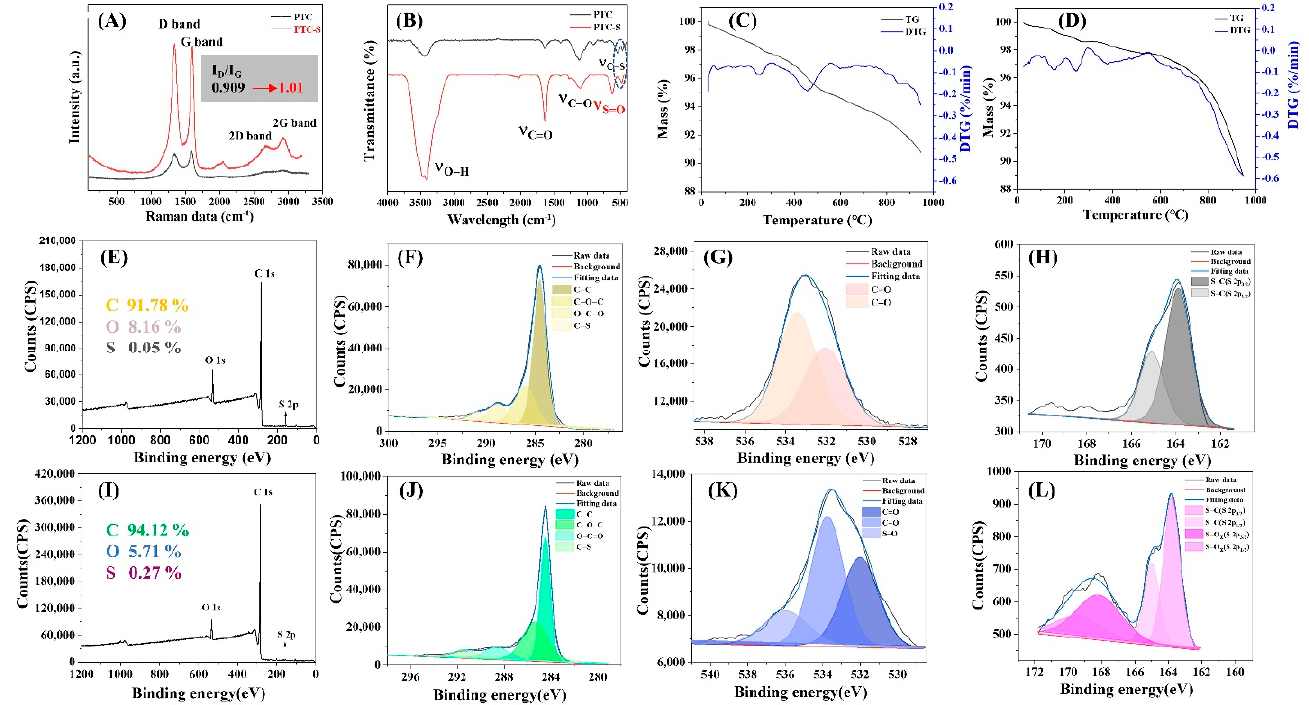
Figure 2. ( A ) Raman spectra and ( B ) FTIR spectra of PTC and PTC-S; ( C ) TG and DTG curves of PTC; ( D ) TG and DTG curves of PTC-S; ( E ) Survey, ( F ) C 1s, ( G ) O 1s, ( H ) S 2p spectra of PTC; ( I ) Survey, ( J ) C 1s, ( K ) O 1s, ( L ) S 2p spectra of PTC-S.